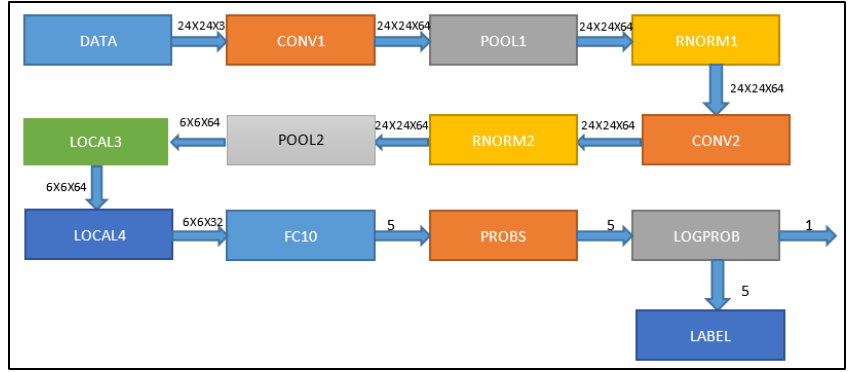
Figure 1. Structure of the convolutional neural network used in this work. Each of the layers is shown accompanied by the dimensionality of the input and output data.